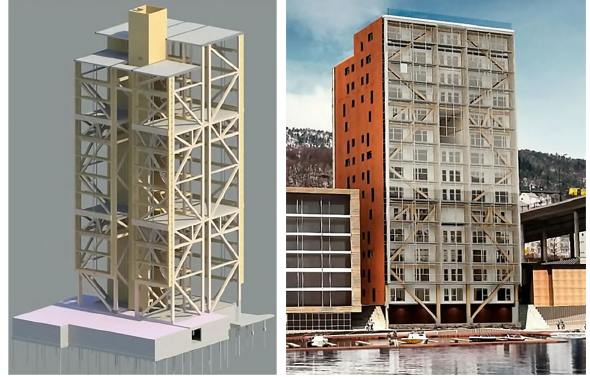
Figure 5. Treet , Bergen, Norway (Malo, Abrahamsen, & Bjertnæs, 2016)